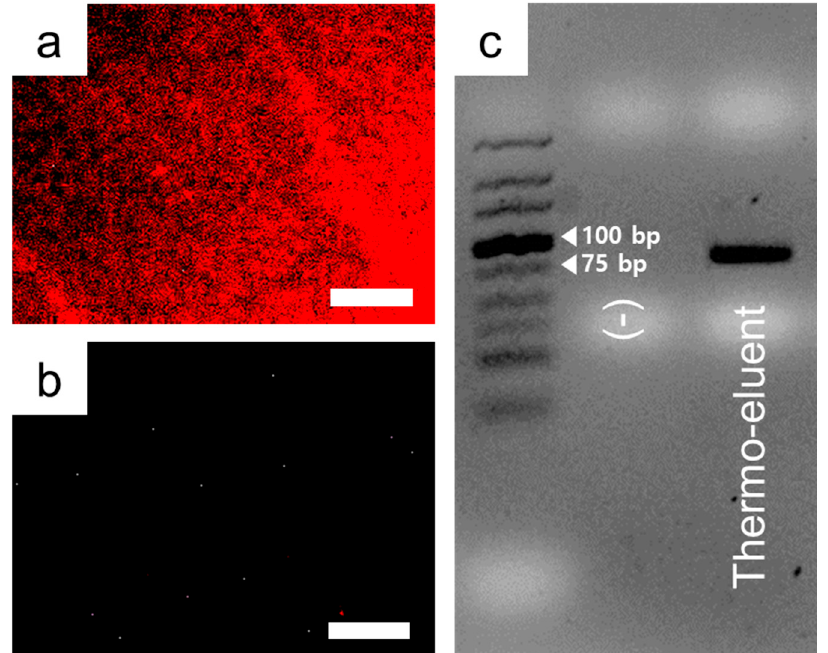
Figure 4. Thermo-elution test for the retrieval of bound aptamers from the target diazinon-containing sol-gel-coated AAO membrane. Fluorescence microscopy images ( a ) before and ( b ) after thermo-elution. ( c ) PCR test for thermo-eluent. Scale bars denote 300 μ m.